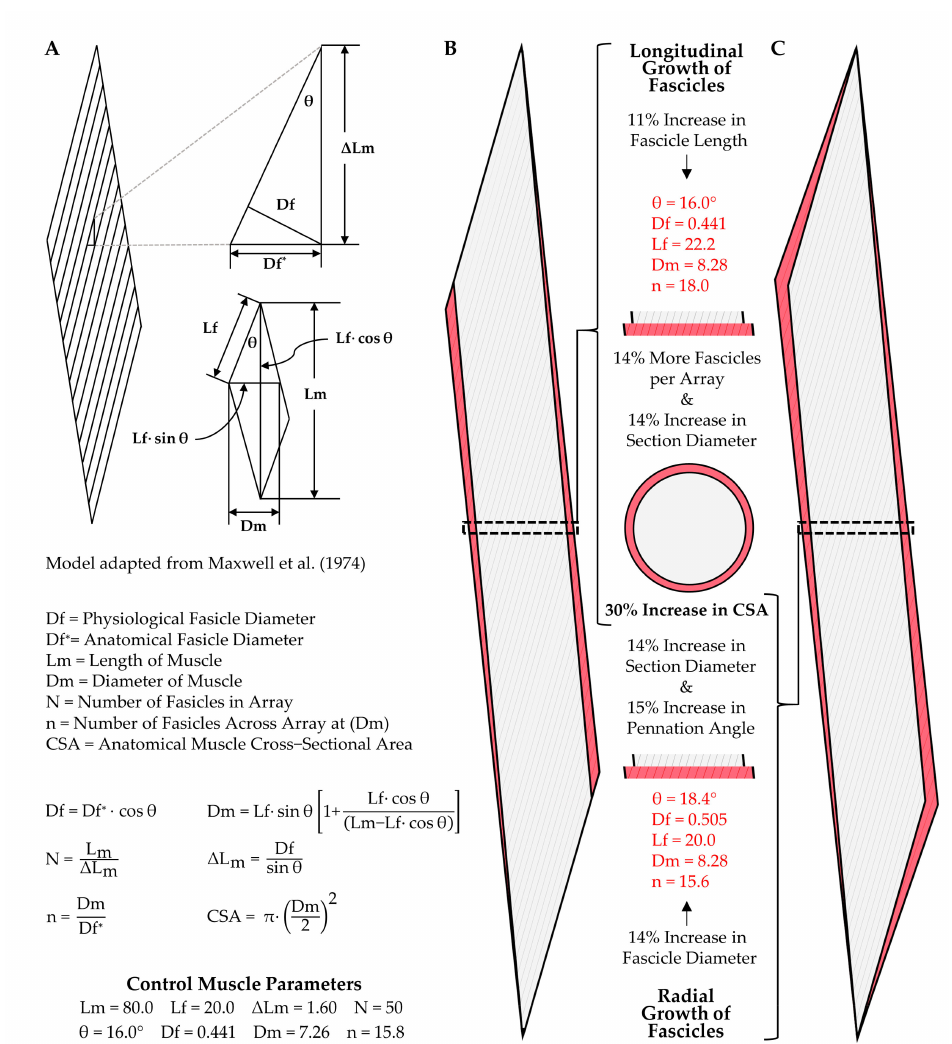
Figure 3. Illustration of how the longitudinal and radial growth of fascicles can lead to changes in muscle cross-sectional area (CSA). ( A ) Key elements of a geometric model that can be used to predict the architectural properties of skeletal muscle [75]. ( B ) Illustration of how an 11% increase in fascicle length would result in 30% increase in CSA, as well as a 30% increase in the number of fascicles per cross-section. ( C ) Illustration of how a 14% in fascicle diameter would lead to a 15% increase in the pennation angle and a 30% increase in the CSA, but essentially no change in the number of fascicles per